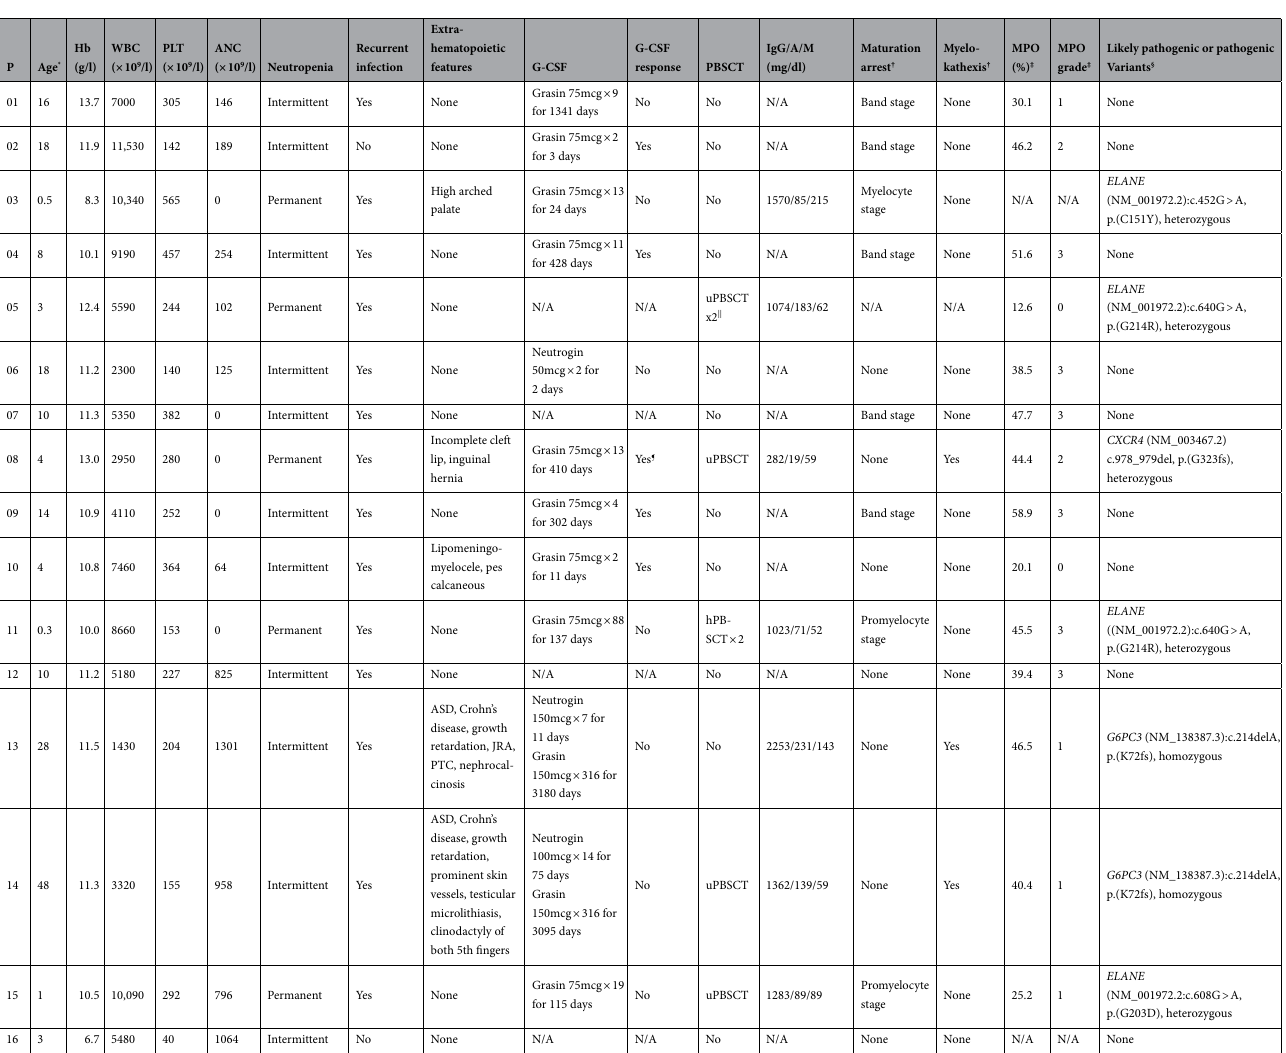
Table 1. Clinical, histologic, cytogenetic and molecular characteristics of 16 neutropenia patients. * Age at initial presentation of neutropenia. † One patient with diluted BM aspiration in which reliable differential count could not be made was excluded. ‡ Two patients were not included due to inadequate BM section quality or retrospectively unavailable BM paraffin block for MPO stain. § Only likely pathogenic or pathogenic variants are documented in this table. Information on all the variants detected including VUS is displayed in Table S3. || One out of 5 (20.0%) who underwent PBSCT died despite two successive uPBSCT. ¶ One patient (P-08) initially responded to G-CSF but then became a non-responder. # Haploidentical PBSCT from father. ANC absolute neutrophil count, ASD atrial septal defect, BM bone marrow, G-CSF granulocyte-colony stimulating factor, Hb haemoglobin, hPBSCT haploidentical peripheral blood stem cell transplantation, JRA juvenile rheumatoid arthritis, M:E myeloid to erythroid, MPO myeloperoxidase, N/A not applicable, P patient, PBSCT peripheral blood stem cell transplantation, PLT platelet, PTC papillary thyroid cancer, uPBSCT unrelated peripheral blood stem cell transplantation, WBC white blood